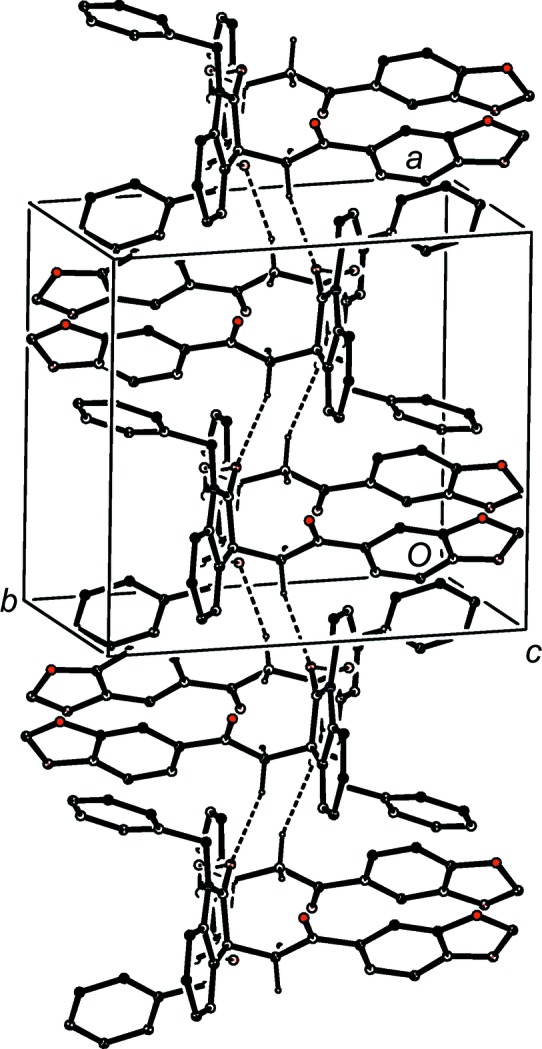
Part of the crystal structure of com­pound (If), showing the formation of a chain of rings running parallel to the [100] direction and built from O—H⋯O and C—H⋯O hydrogen bonds. Hydrogen bonds are drawn as dashed lines and, for the sake of clarity, H atoms not involved in the motifs shown have been omitted.